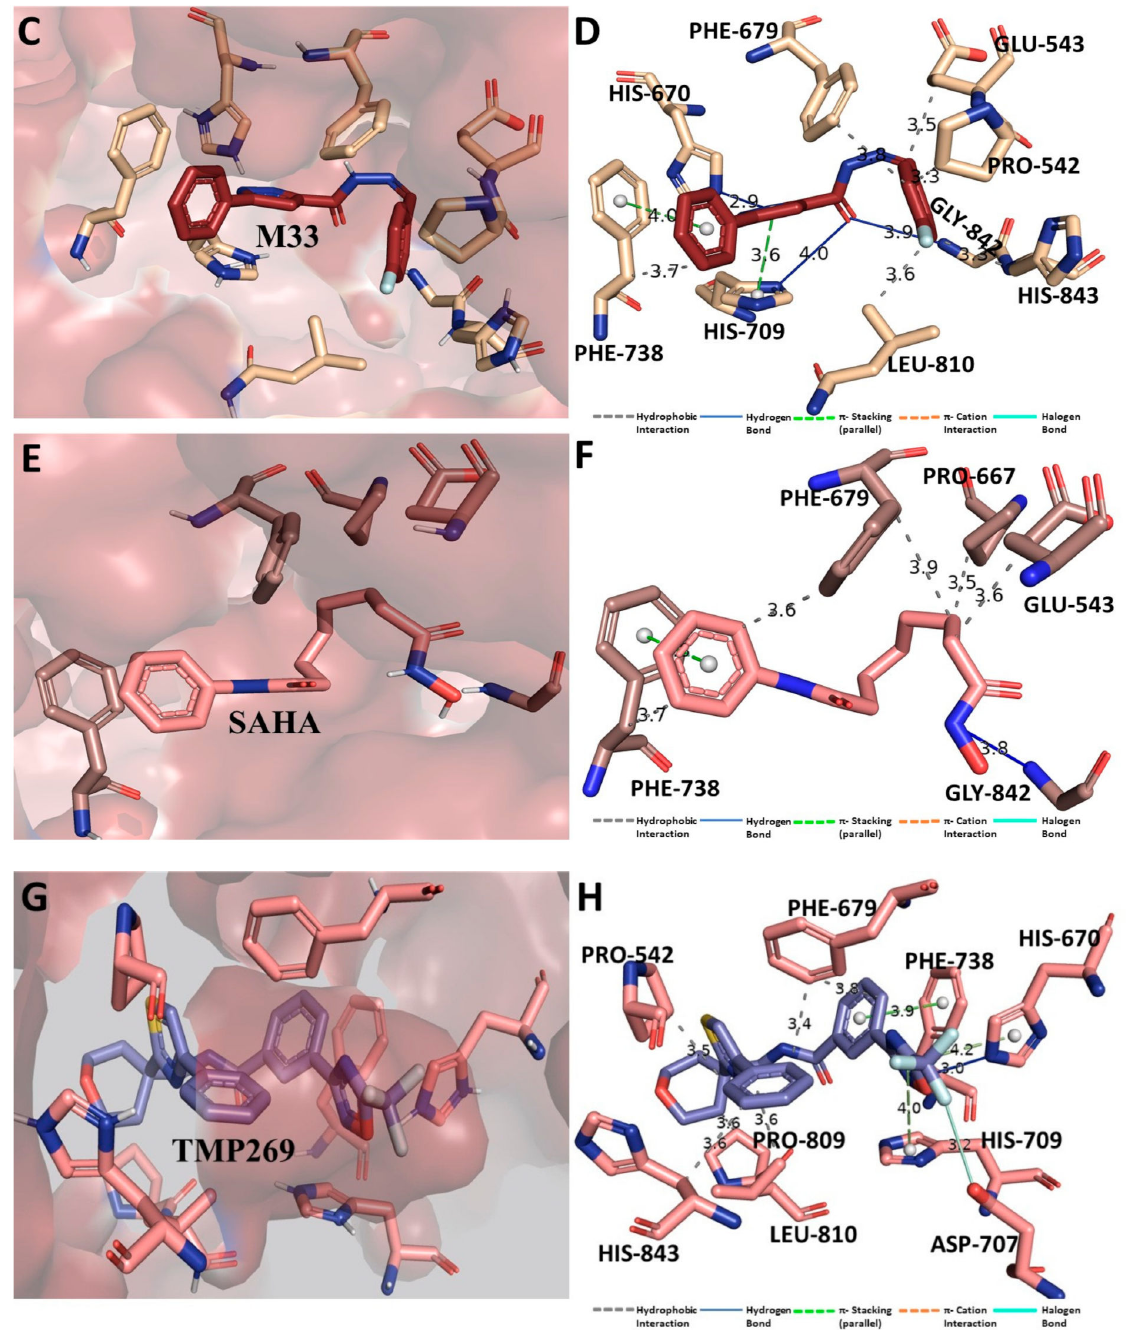
Figure 12. ( A ) Molecular docking-generated binding orientations of all standard compounds (SAHA; TMP269) and the proposed pyrazole inhibitor compound M33 in complex with HDAC7 (3ZNR) protein; ( B ) close-up binding interaction view exhibiting similar binding pattern of all the standard compounds including M33 at the active site cavity of HDAC7 (3ZNR) protein; ( C ) binding mode of the pyrazole derivative compound M33 in the active site cavity of HDAC7 (3ZNR) displayed in surface view; ( D ) molecular binding interaction and orientation of compound M33 with HDAC7 (3ZNR) protein; ( E ) binding mode of standard inhibitor (SAHA) in the active site cavity of HDAC7 (3ZNR) displayed in surface view; ( F ) molecular binding interaction and orientation of SAHA with HDAC7 (3ZNR) protein; ( G ) binding mode of standard compound TMP269 in active site cavity of HDAC7 (3ZNR) displayed in surface view; ( H ) molecular binding interaction and orientation of TMP269 with HDAC7 (3ZNR)